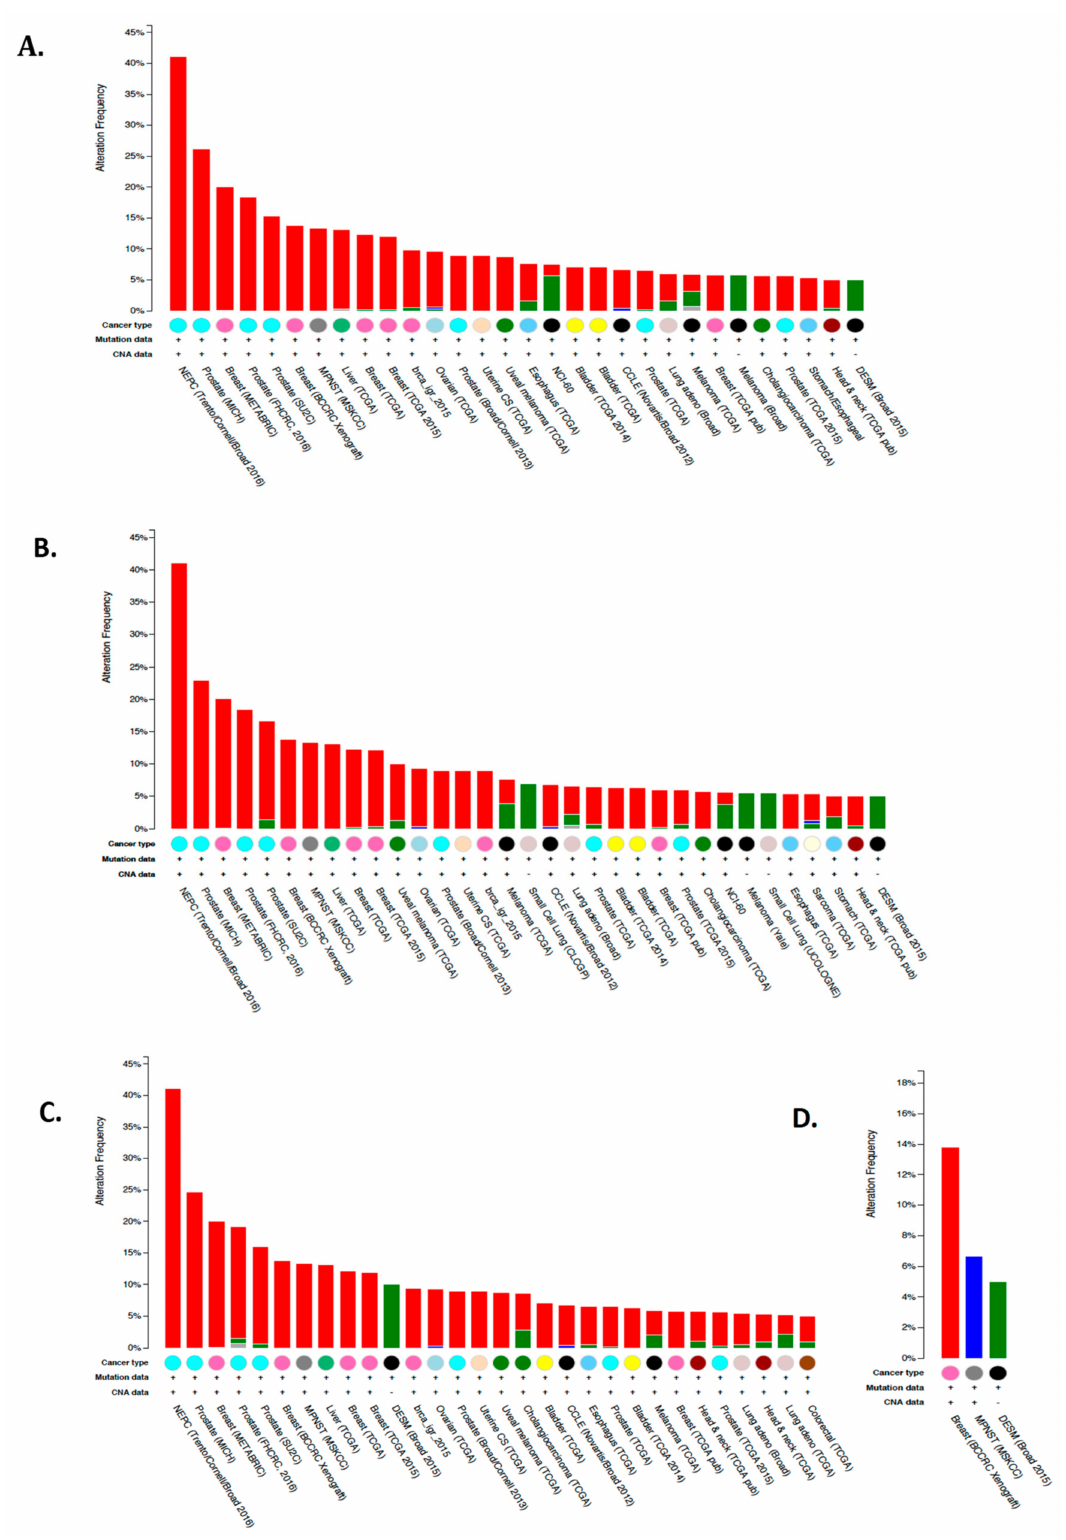
Figure 3. Summary of cross-cancer alterations for CA isoforms. ( A ) CA I, ( B ) CA II, ( C ) CA III, and ( D ) CA VII. Gene amplifications are shown in red, mutations in green, deletions in blue, and multiple alterations in gray. The minimum percent altered samples threshold was set to 5%. The data and results were obtained from the cBioPortal of the human genome atlas (TCGA) [141,142]. Experimental details of each study referenced can also be found in the TCGA